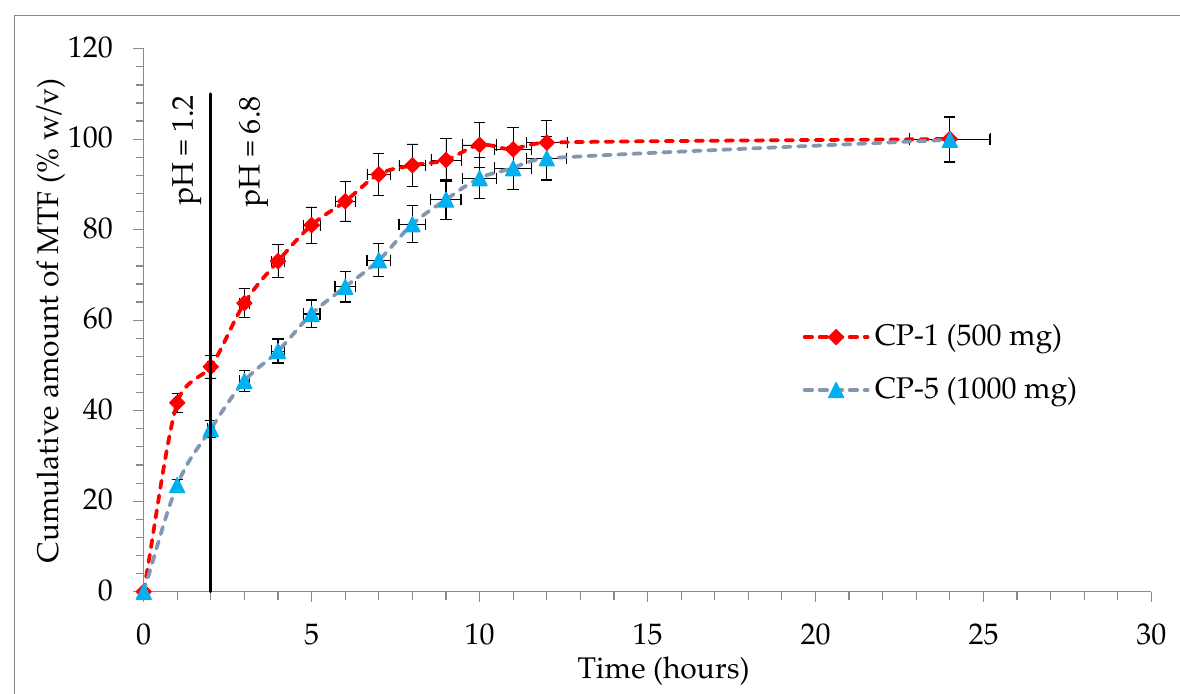
Figure 7. Release profile of M-HCl from prolonged-release tablets.